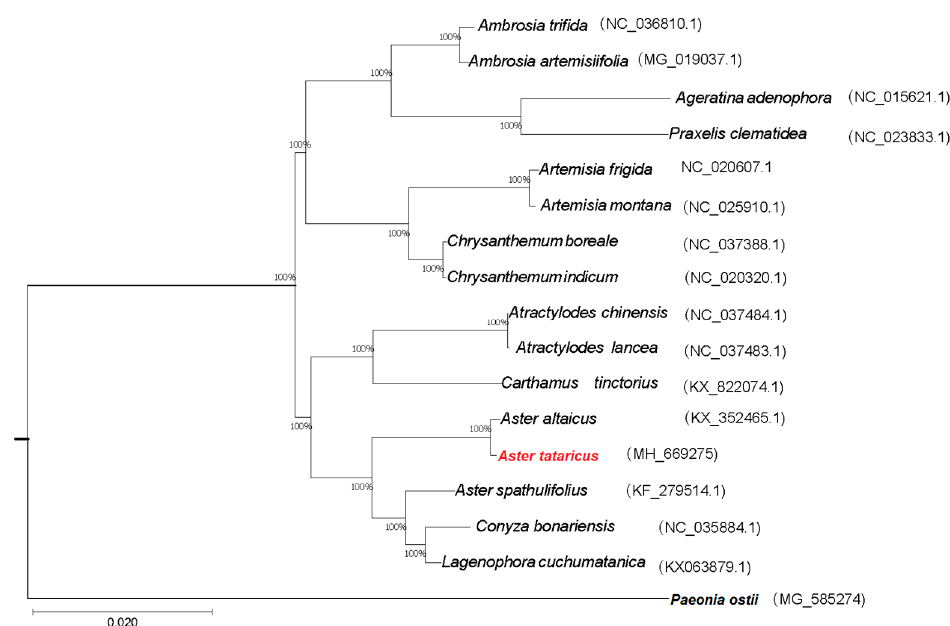
Figure 5. Maximum likelihood (ML) phylogenetic tree reconstruction including 17 species based on concatenated sequences from all chloroplast genomes. The position of A. tataricus is indicated in red text. Paeonia ostii was used as the outgroup.